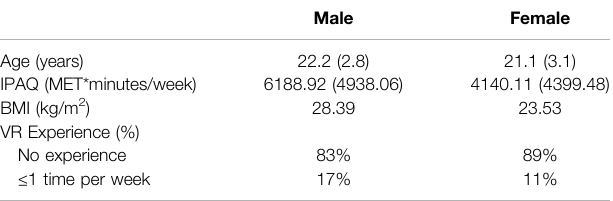
TABLE 2 | Descriptive statistics of sample (Means and